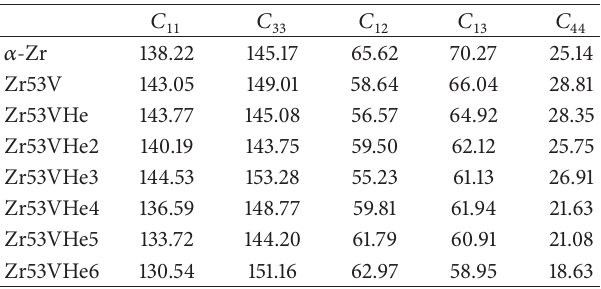
Table 4: Elastic constants 𝐶 𝑖𝑗 (in GPa) of 𝛼 -Zr and Zr-V-He systems.